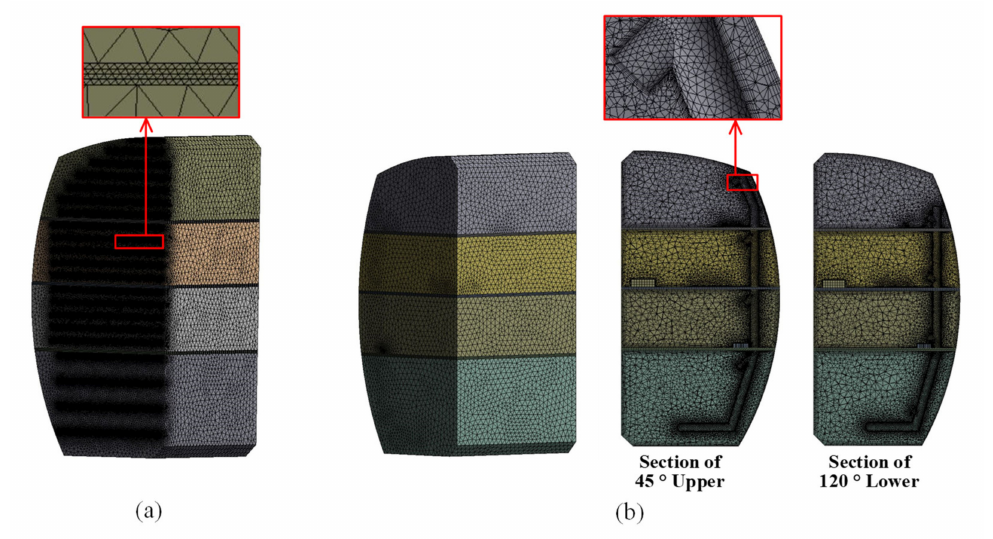
Figure 5. Mesh configuration. ( a ) Mesh configuration of new air cooling system; ( b ) Mesh configuration of traditional air cooling system.